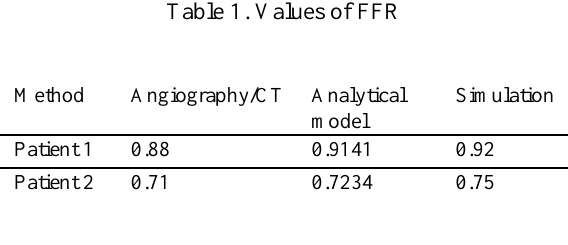
Figure 3. CT image of left coronary artery